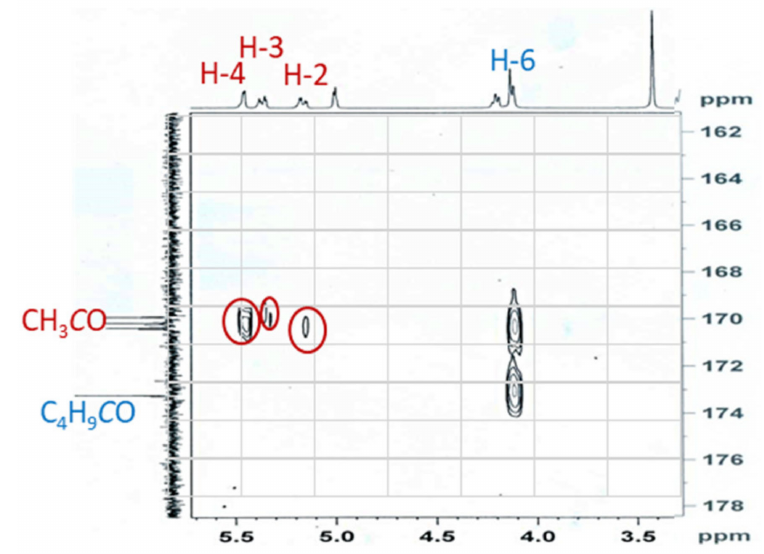
Figure 3. The HMBC correlations for CO groups of 6